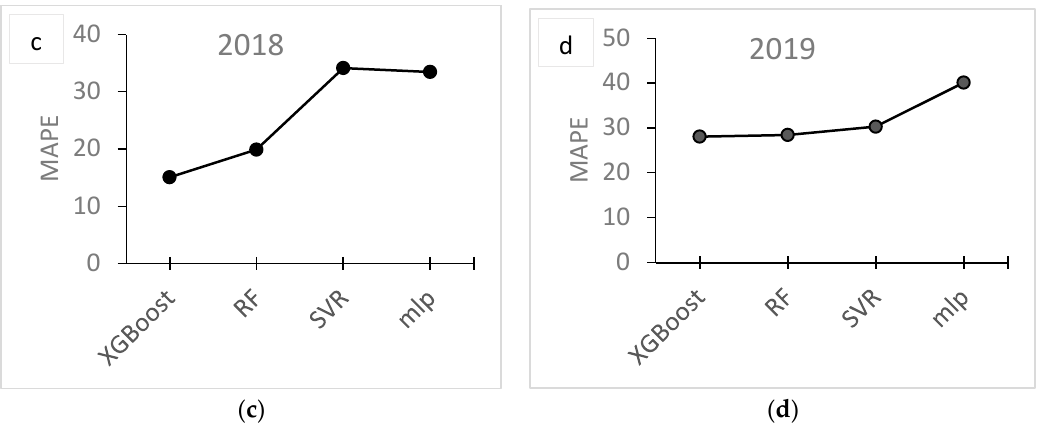
Figure 11. Root mean square error (RMSE) ( a , b ) and mean absolute percentage error ( c , d ) of DPPH prediction using XGBoost, random forest (RF), support vector regression (SVR) and multiple perceptron (MLP) models for 2018 ( a – c ) and 2019 ( b , d ).